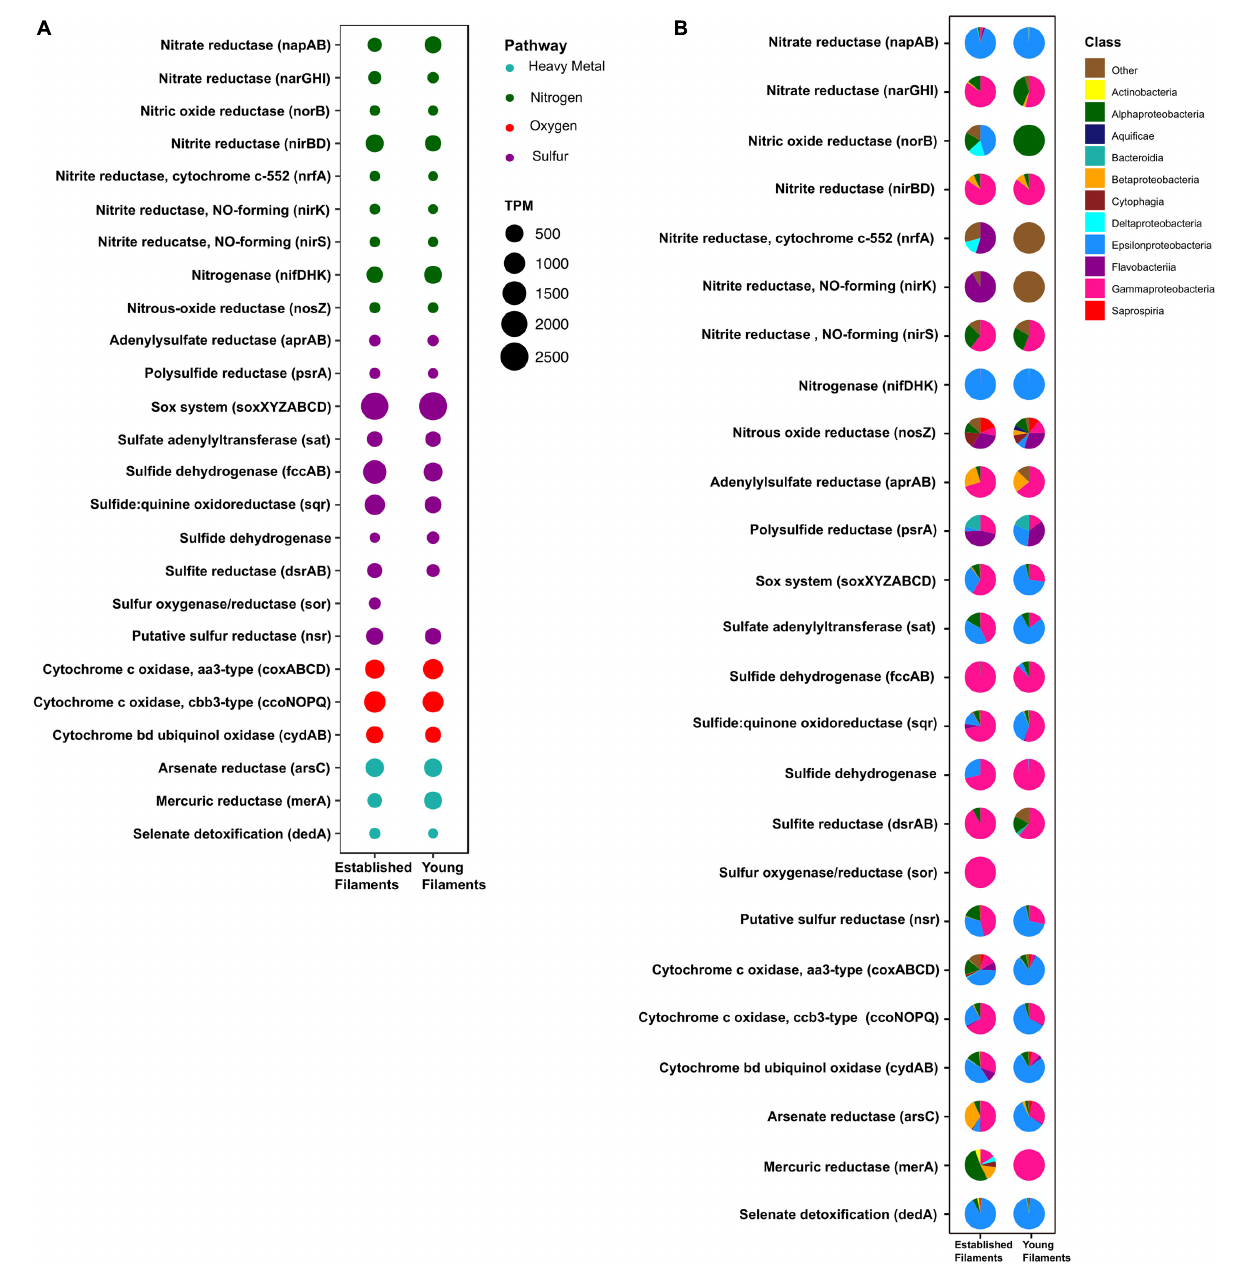
FIGURE 3 | (A) Transcripts per million (TPM) and (B) taxonomic affiliation of reads annotated to key genes involved in nitrogen, sulfur, oxygen and heavy metal detoxification pathways for established and young